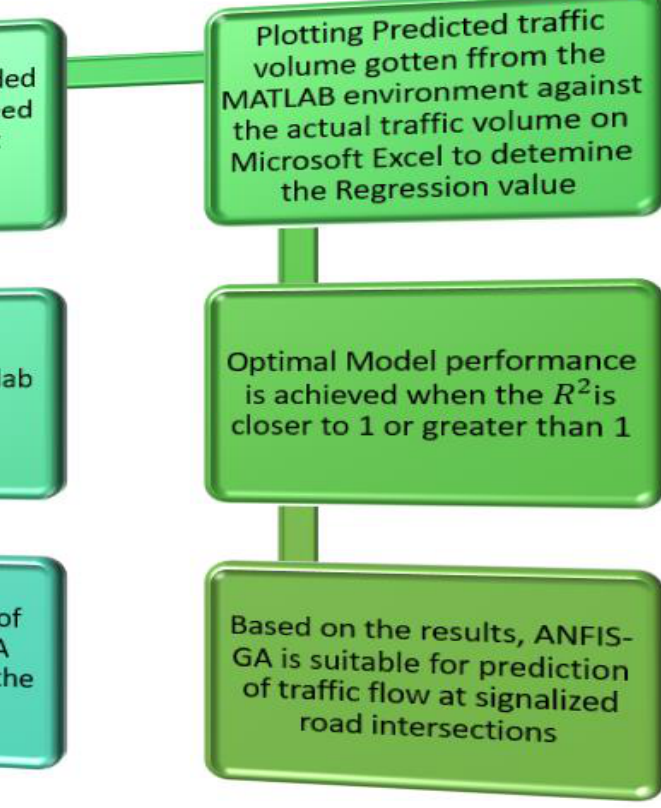
Figure 1. Methodological approaches of the study.